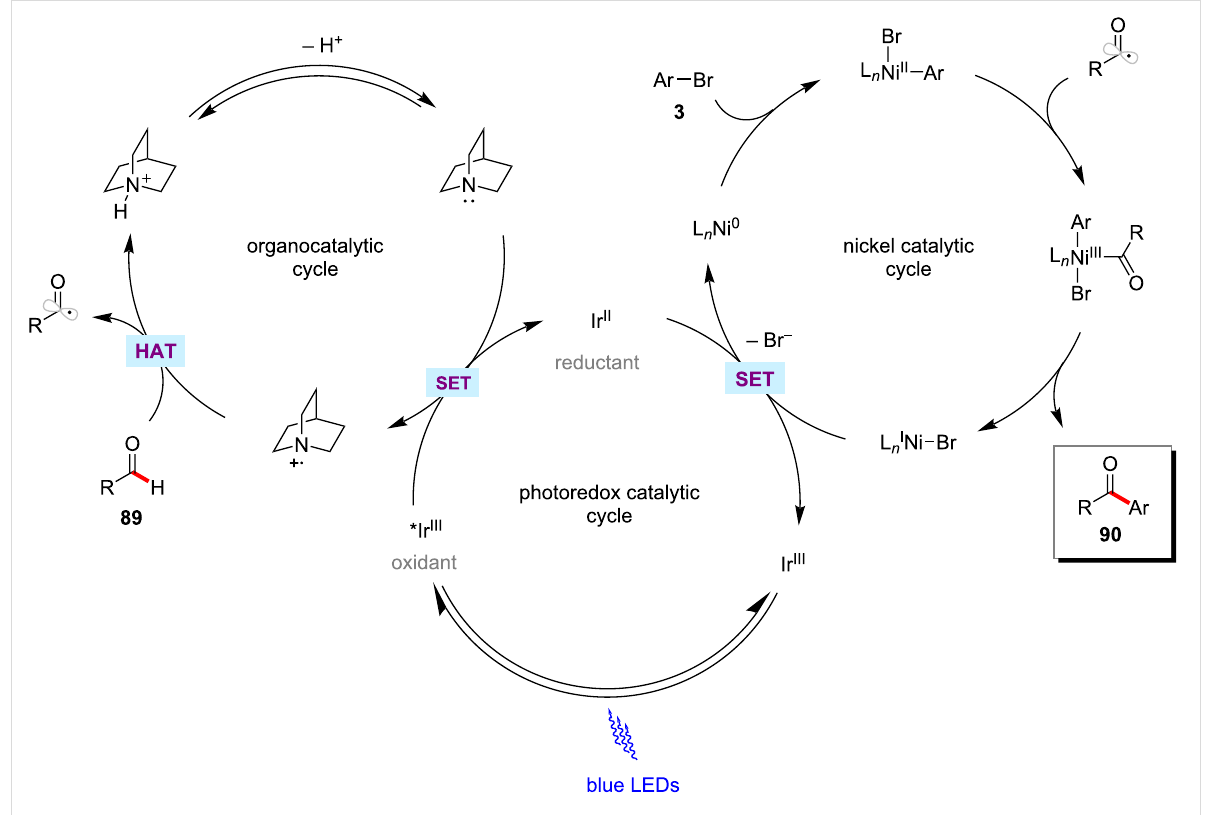
Figure 20: Proposed catalytic cycle for the photoredox nickel-catalyzed aldehyde C–H functionalization.